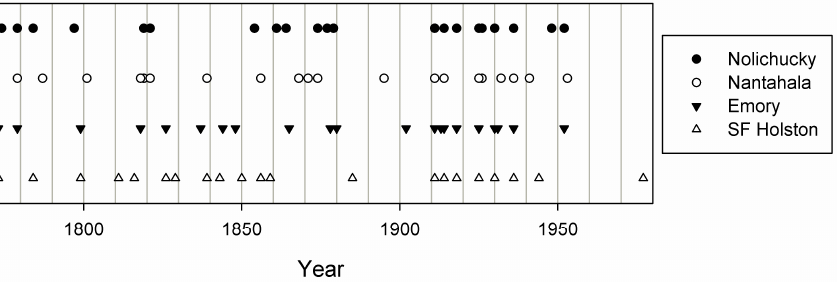
Figure 5. Distribution of the May–June–July flows in the lowest 10th percentile for the streamflow reconstructions from 1772 to 1980.